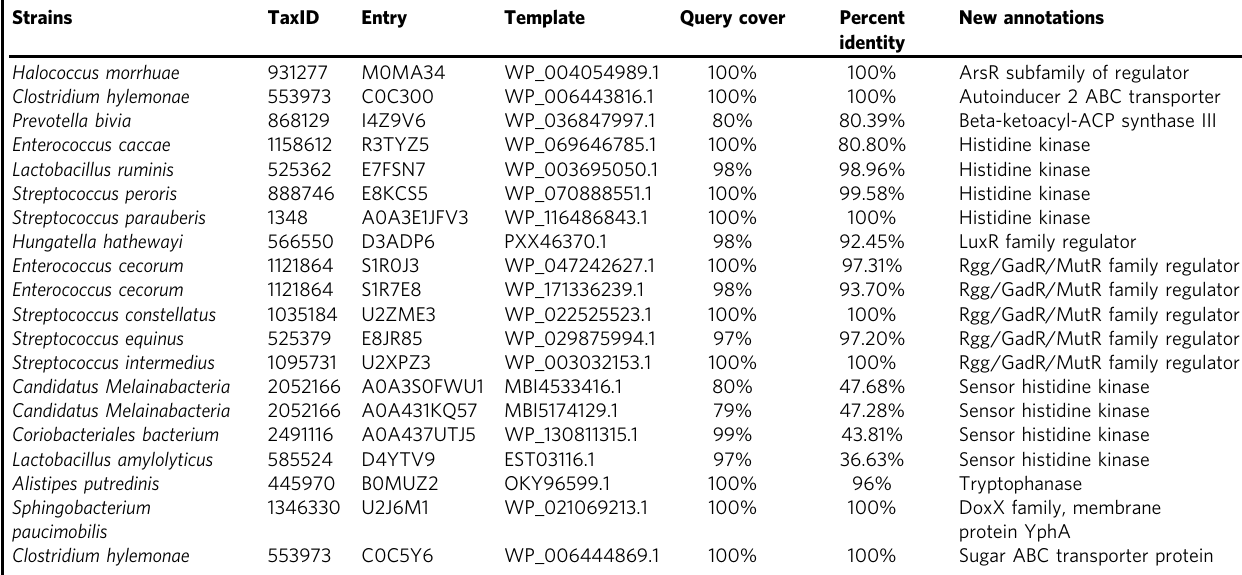
Table 1 Results of 20 expanded entries without existing annotations based on the web BLASTP.